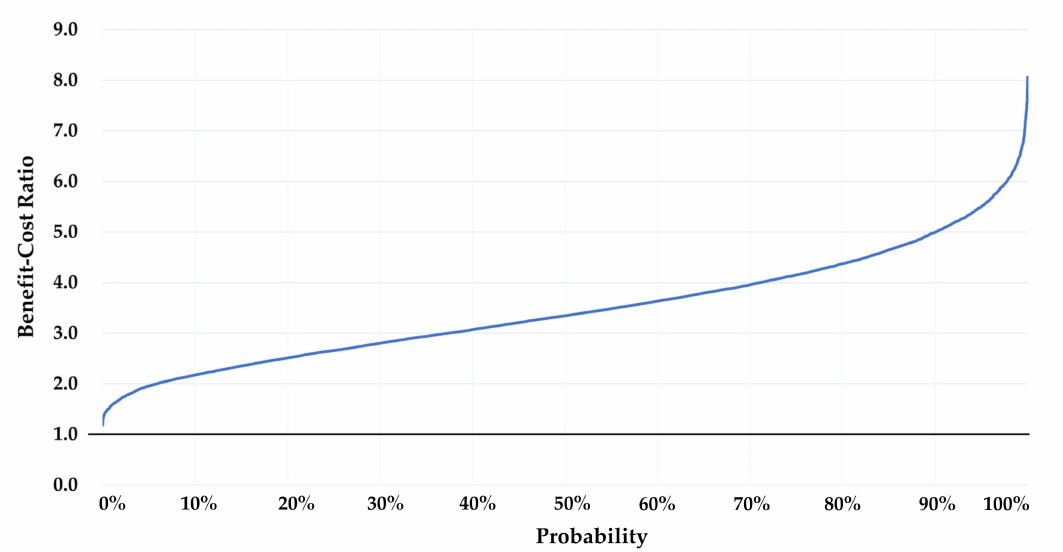
Figure 5. Cumulative probability of the benefit–cost ratio (Monte Carlo analysis, x -axis: cumulative percentage, and y -axis: benefit–cost